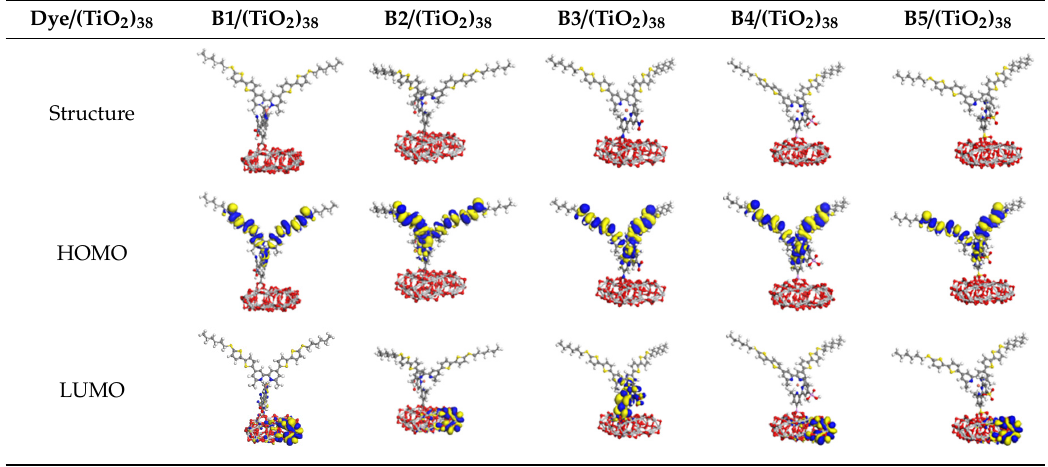
Molecules 2020 , 25 , x FOR PEER REVIEW